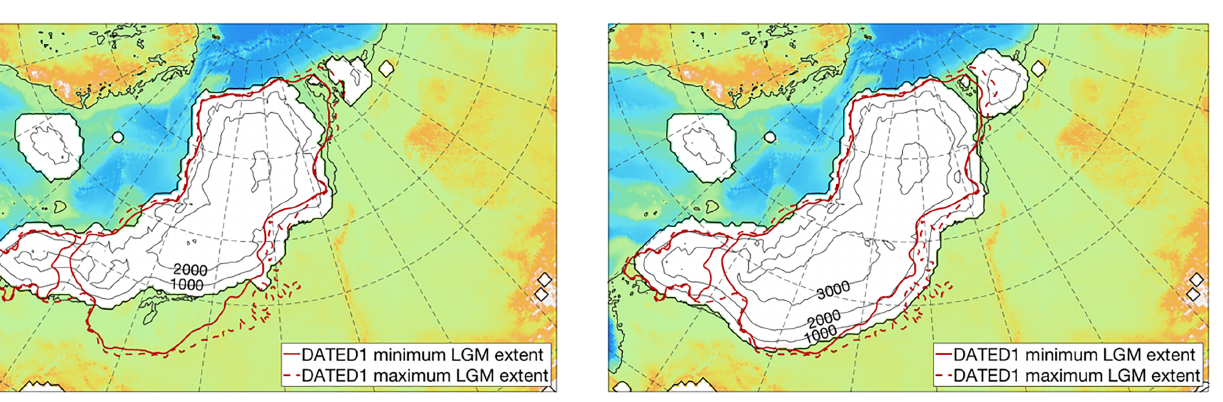
Figure 9. Comparison of the simulated Eurasian ice sheet at the LGM with the DATED-1 reconstruction (Hughes et al., 2016). Con- tour lines show ice thickness. The modelled ice sheet has a volume of 17m sea-level equivalent, in agreement with the 17m of the ICE- 5G reconstruction, whereas the DATED-1 ice sheet is equivalent to 24m sea level.